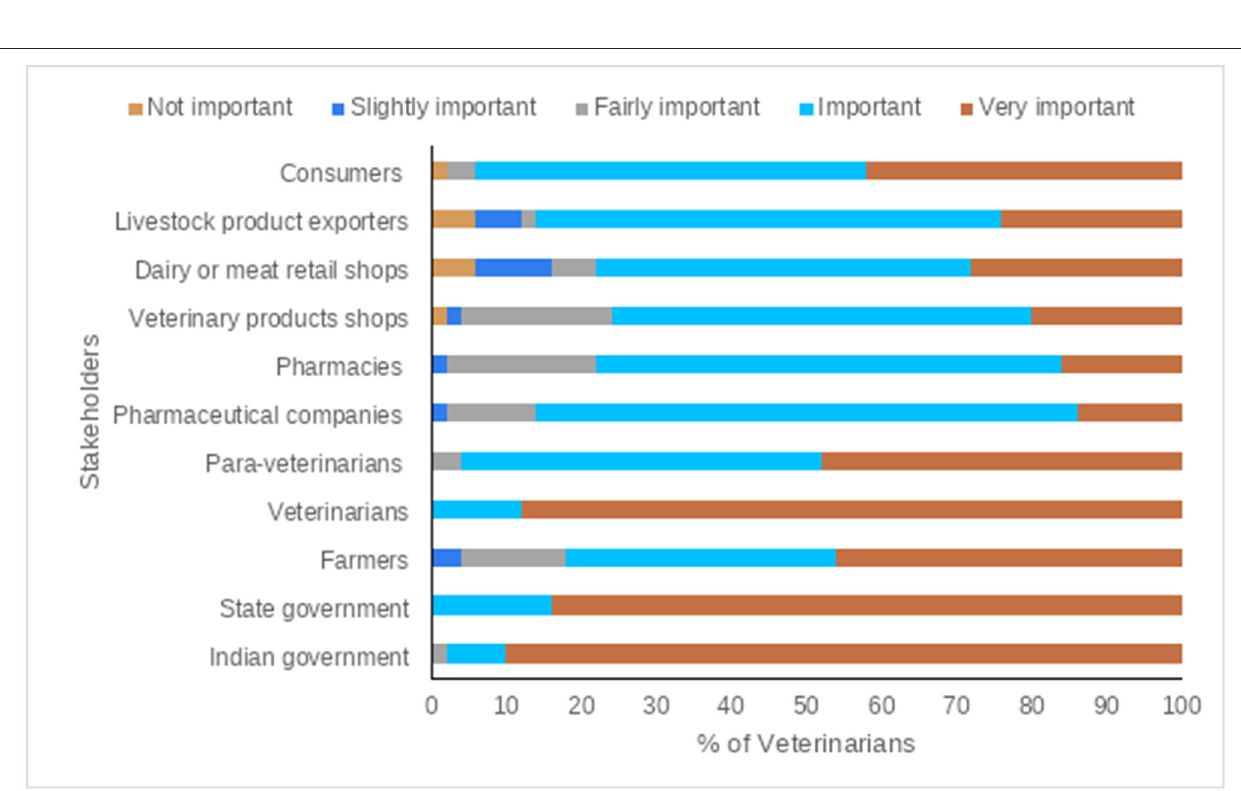
Frontiers in Veterinary Science |